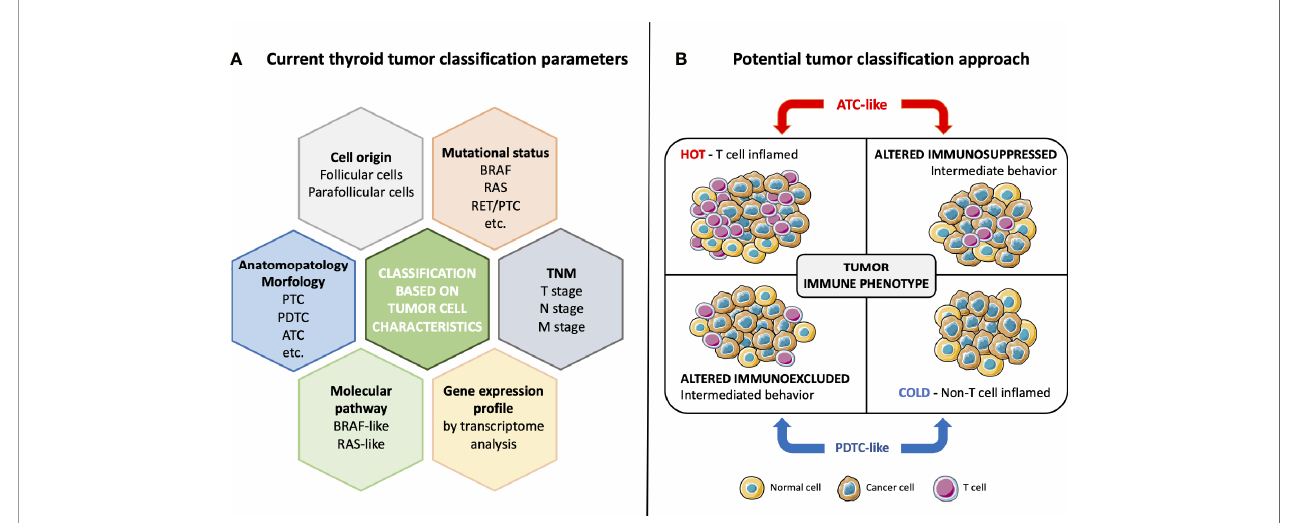
FIGURE 2 | Current thyroid tumor classi fi cation based on cancer cell characteristics (A) and potential classi fi cation approach based on immune phenotype (B) . Classical classi fi cation takes into account cell origin, morphology, mutational status, altered molecular pathways, TNM stage, and signature of the tumor. The speci fi c interaction between tumor and immune system determines the tumor immune phenotype. ATC-like tumors, presenting T cell in fi ltration both in the tumor center and in invasive margin or only in the tumor center, have a hot or altered immunosuppressed phenotype. Conversely, PDTC-like tumors have a cold or an altered immunoexcluded phenotype, with not or poor T cell in fi ltration only at invasive